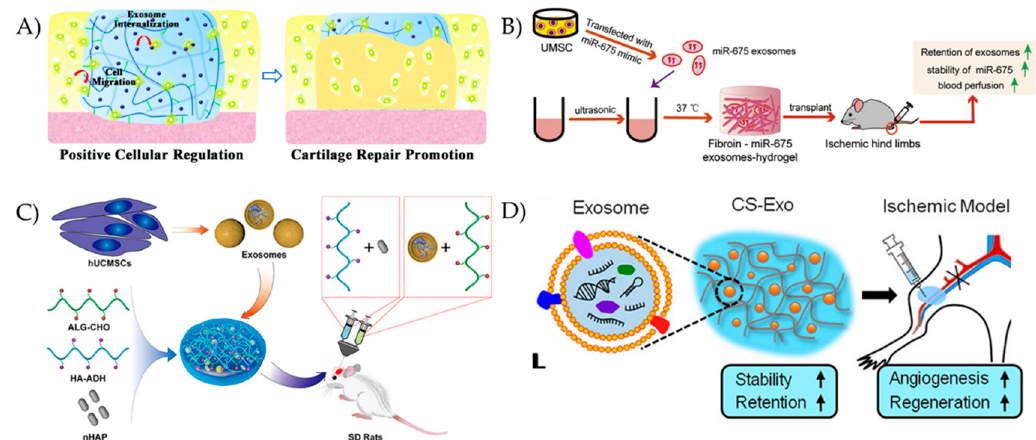
Figure 4. ( A ) Schematic illustration of the exosome-hydrogel scaffold for cartilage regeneration. Reproduced with permission from [109], Royal Society of Chemistry, 2017. ( B ) Schematic illustration of the miR-675-loaded exosome-silk fibroin hydrogel system for age-induced vascular dysfunction treatment. Reproduced from [112], Elsevier, 2019. ( C ) Schematic illustration of the exosome-hyaluronic acid-alginate hydrogel system for bone regeneration. Reproduced with permission from [110], American Chemical Society, 2020. ( D ) Schematic illustration of the exosome-chitosan hydrogel system for muscle regeneration. Reproduced with permission from [18], American Chemical Society, 2018.